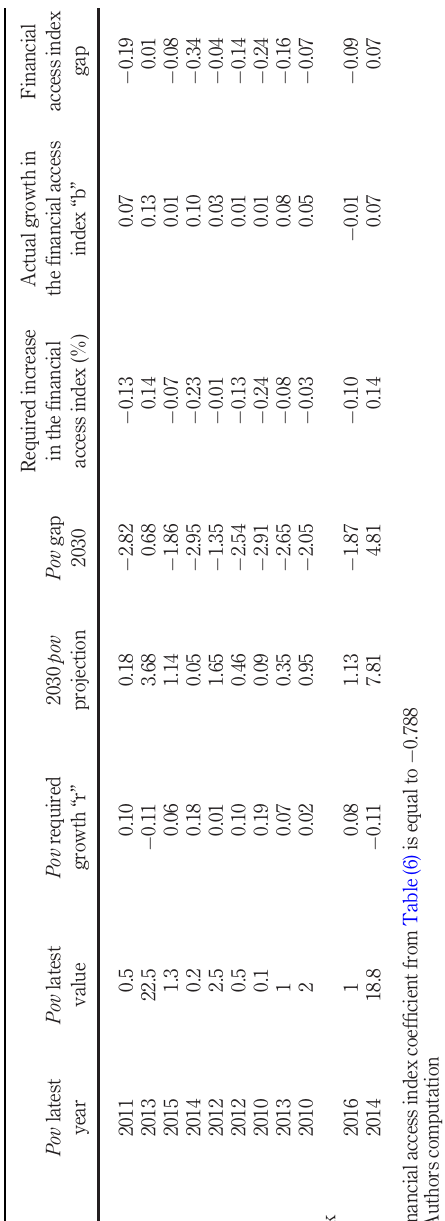
Table A9. Extreme poverty and financial access gap analysis in MENA region – assessment against the 3% poverty